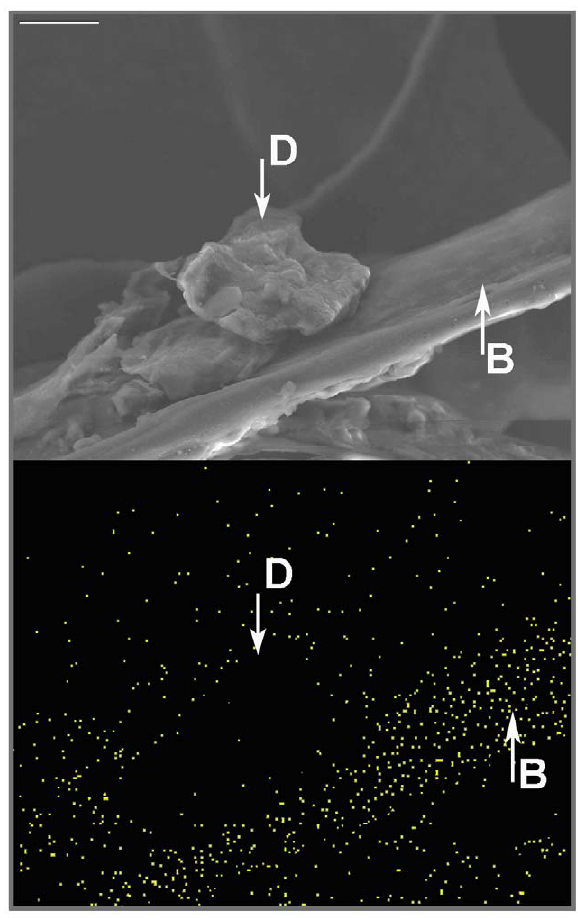
Figure 3. Soiling on black-capped chickadee feathers. Micro- graph of soiled barb of a white black-capped chickadee feather (upper panel) and corresponding EDX dot map of sulfur (lower panel). Yellow dots in bottom panel indicate the presence of sulfur corresponding to keretinous structures. d =debris, b =barb. Scale bar is 10 m m.